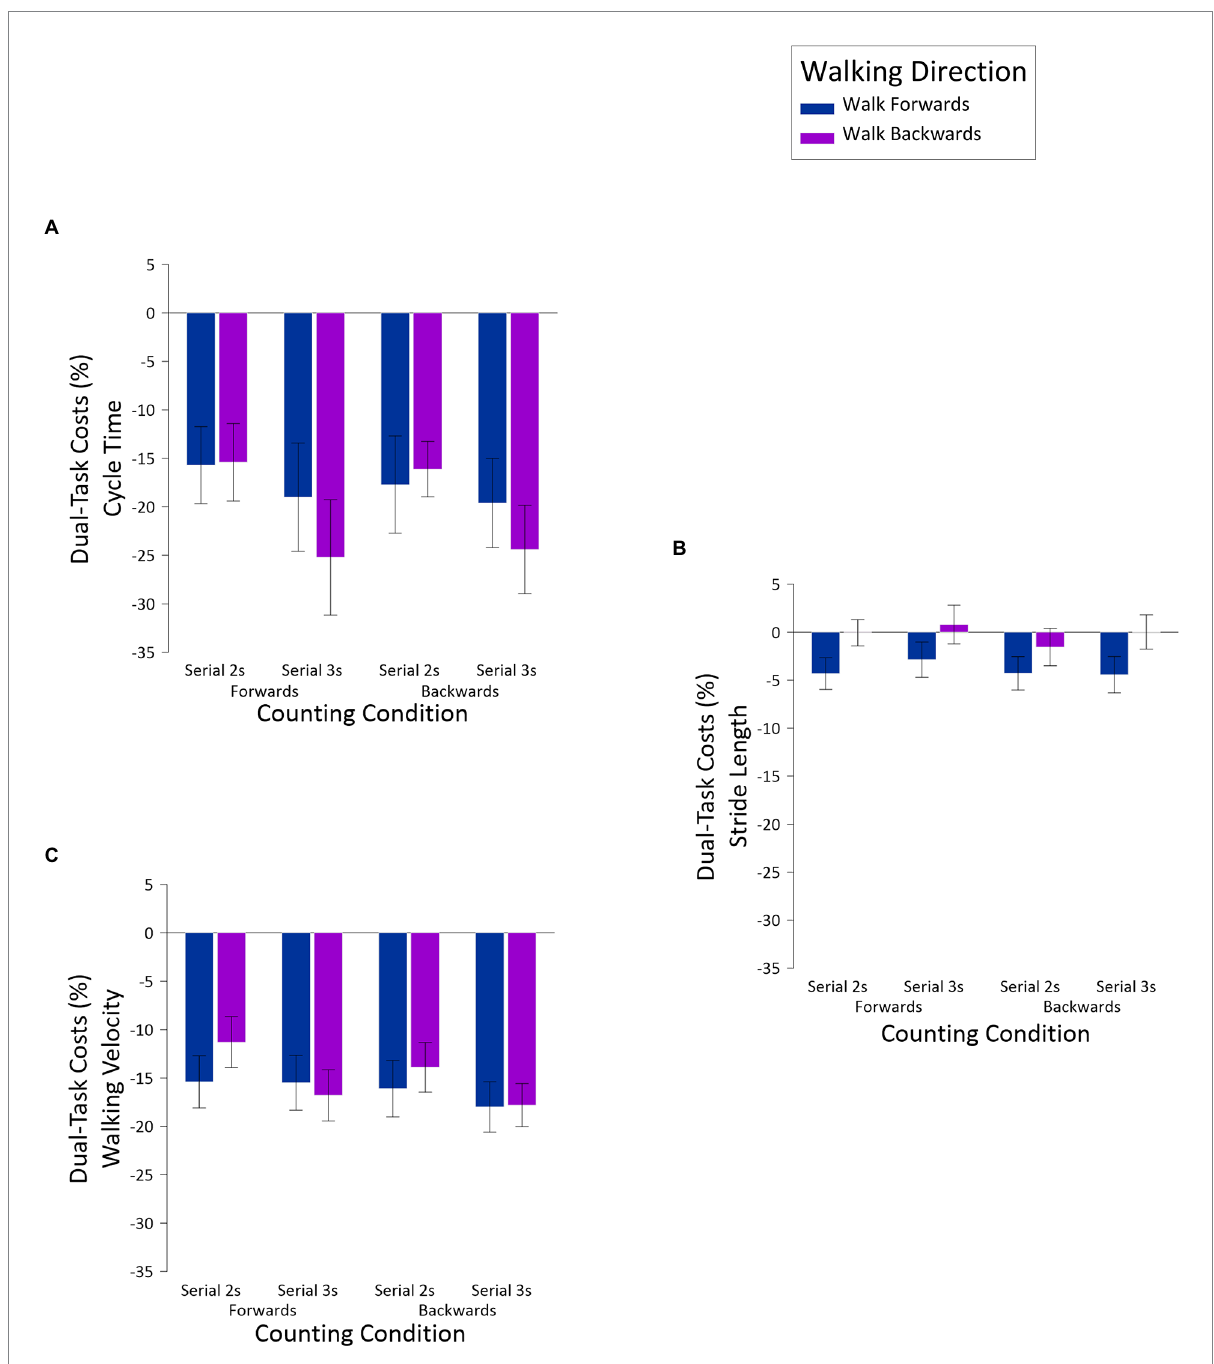
FIGURE 2 Dual-task costs for cycle time (A) , stride length (B) , and walking velocity (C) , as a function of Walking Direction, Counting Direction and Counting Difficulty